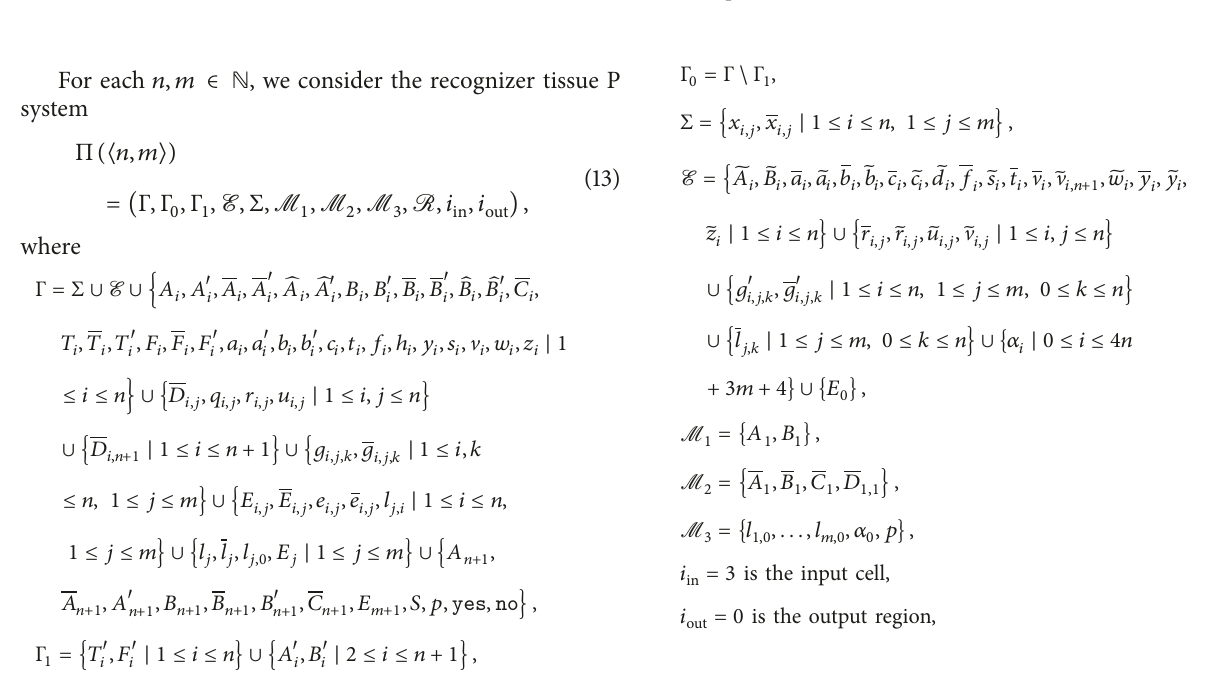
Algorithm 1: Selection